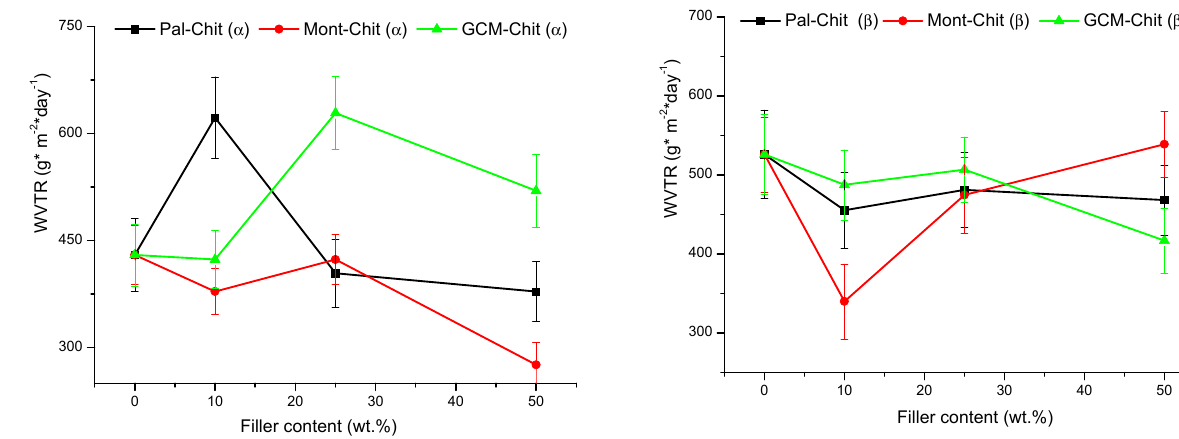
Figure 5. Changes in the water vapor transmission rate of the films investigated as a function of the filler additions. Chit: chitosan; Pal: palygorskite; Mont: montmorillonite; GCM: geopolymer-containing material.